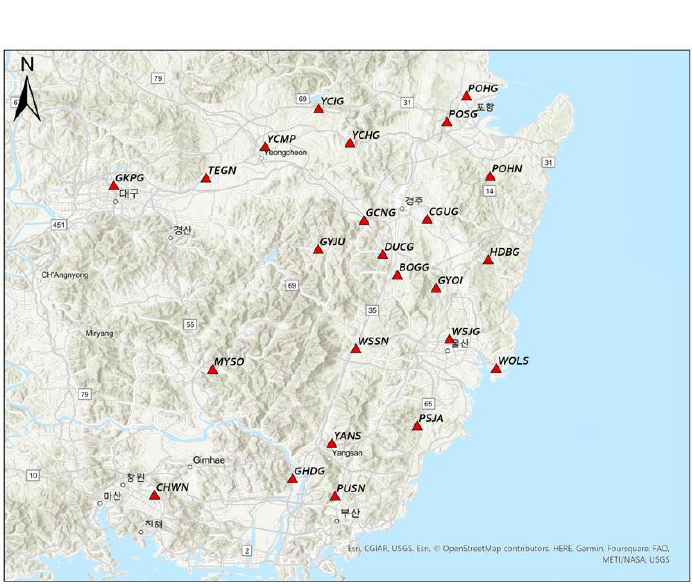
Figure 2. The 24 domestic stations used in the paper. The area around the Yangsan Fault; 7 are operated by KIGAM and 15 are operated by NGII. Table 1. A list of domestic GNSS stations.